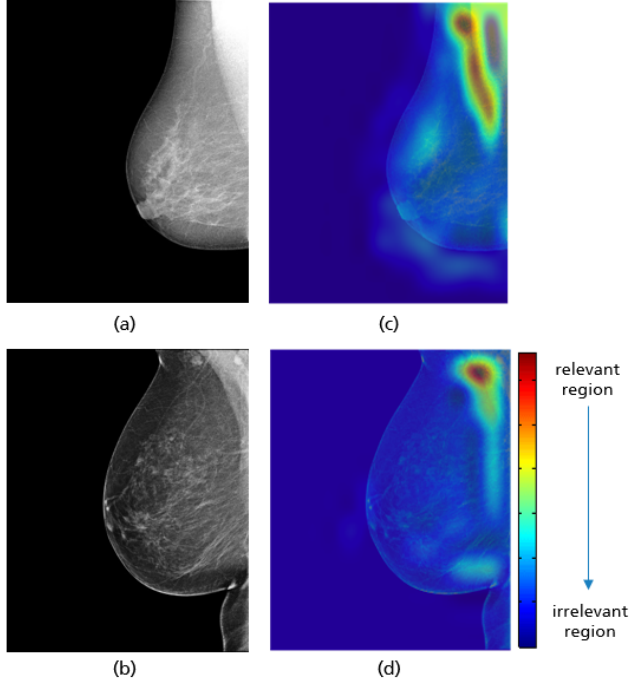
Figure 18. Original MLO views with correct ( a ), inadequate pectoralis muscle angle ( b ) and their Grad-CAM ( c , d ) highlighting the relevant region for the model prediction. Red indicates areas of high relevance. The color distribution extends to a blue area indicating low